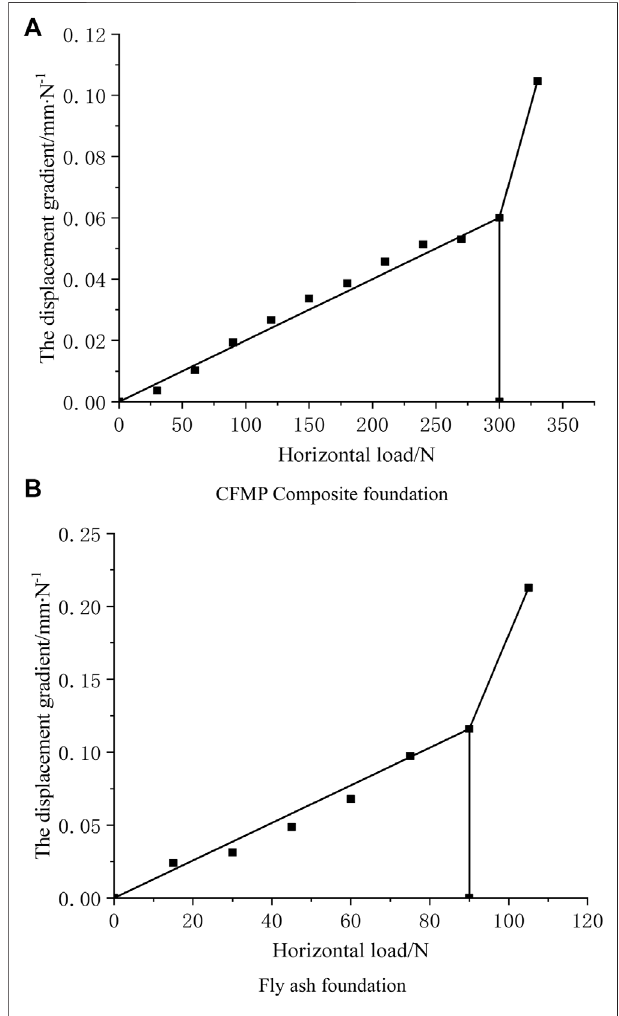
FIGURE 7 | Horizontal force – displacement gradient curve of composite foundationunderstaticload. (A) Horizontalforce-displacementgradientcurve of CFMP composite foundation. (B) Horizontal force-displacement gradient curve of fl y ash